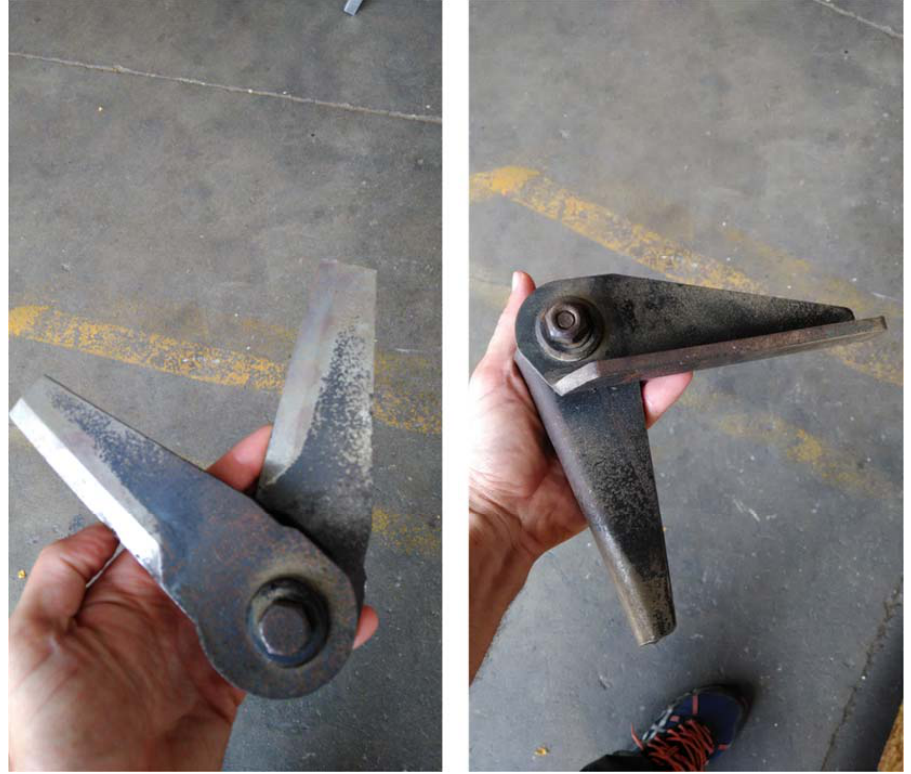
Figure 2. Knives for harvesting wheat chaff (left) and maize cob (right).